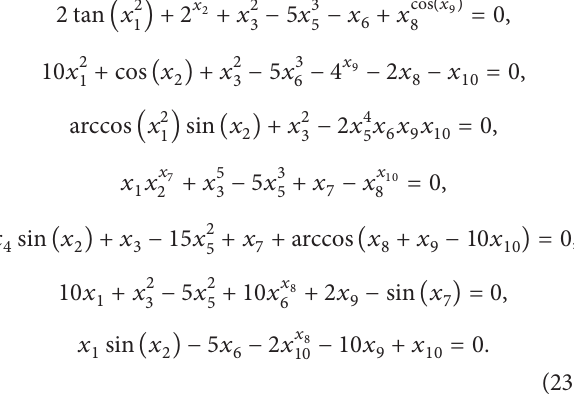
and propose an inversion-free method for solving nonlinear systems of equation in what